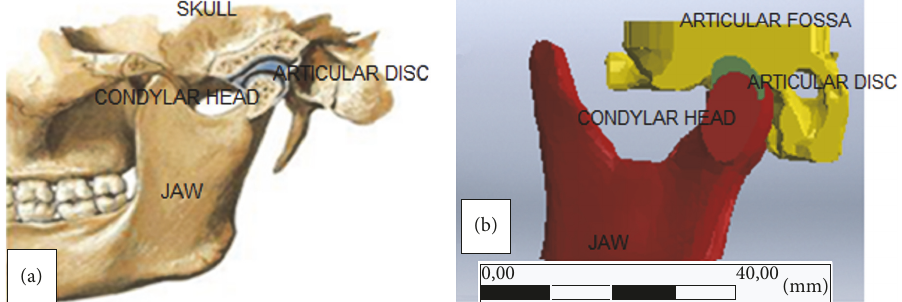
Figure 3: Human anatomy illustrated by Netter (a) and cut model created showing the joint disc (b). Source: adapted from Netter [7].